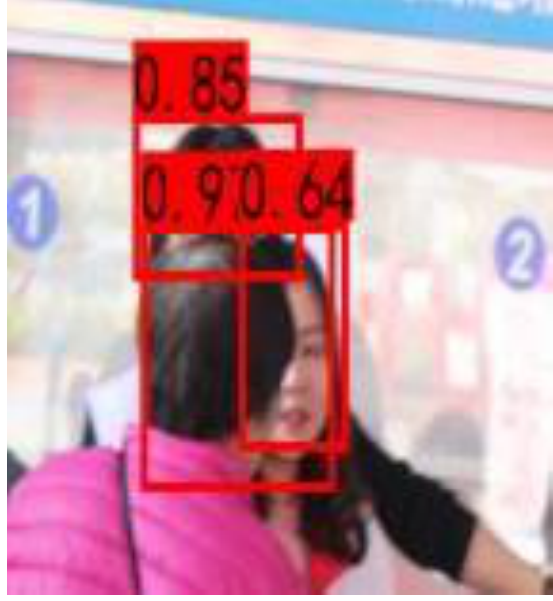
Figure 4. Soft-NMS processing, no missed detection.